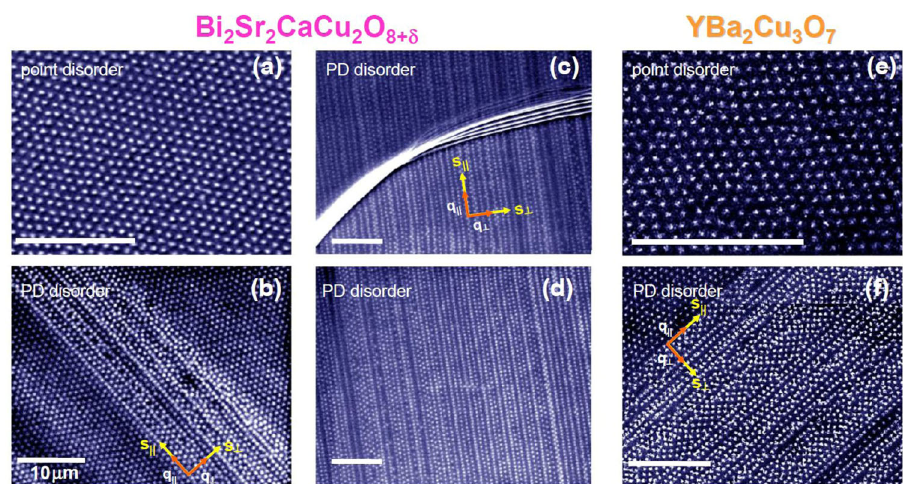
Fig. 1 Magnetic decoration imaging of vortices in samples with point and planar defects. Vortices (white dots) nucleated at 30 G in Bi 2 Sr 2 CaCu 2 O 8 + δ ( a – d ) and YBa 2 Cu 3 O 7 ( e , f ) samples with point ( a , e ) and planar ( b , c , d , f ) disorder. Vortices nucleated on planar defects are seen as vortex rows with a density in general larger than the average. Results in Bi 2 Sr 2 CaCu 2 O 8 + δ samples presenting few ( b ) and many ( c , d ) planar defects in millimeter-sized crystals. ( c ) Illustration on how the planar defects extend on the bulk of the sample: The vortex rows continue in the same in-plane direction in the vicinity of a micron-height step generated by cleaving. The s ∥ - s ⊥ coordinate system oriented along and perpendicular to the planar defects (PD), and the corresponding wave vectors q ∥ and q ⊥ , are shown in some images. White scale bars correspond to 10 μ m and labels indicating the dominant disorder are shown in each